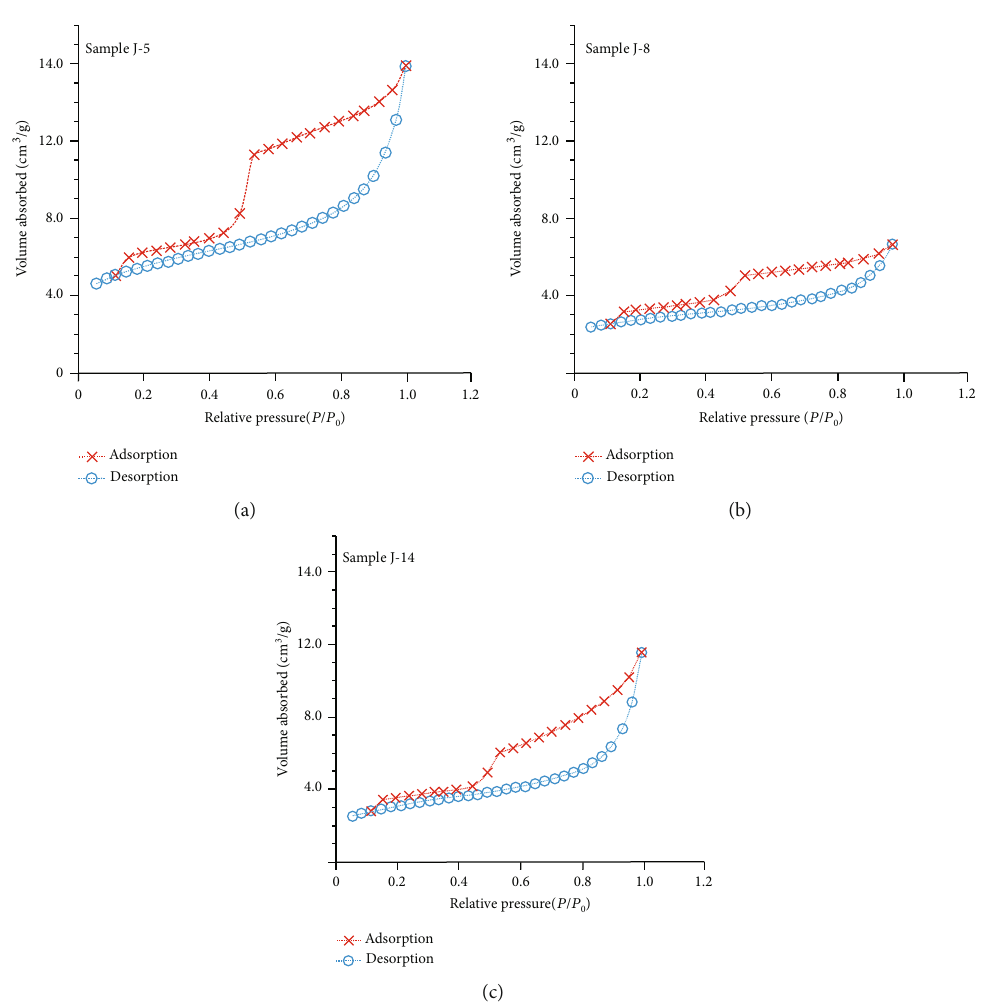
Figure 4: N adsorption-desorption isotherms of Longtan shales ( P 0 — saturated vapor pressure, MPa; P — equilibrium pressure, 2